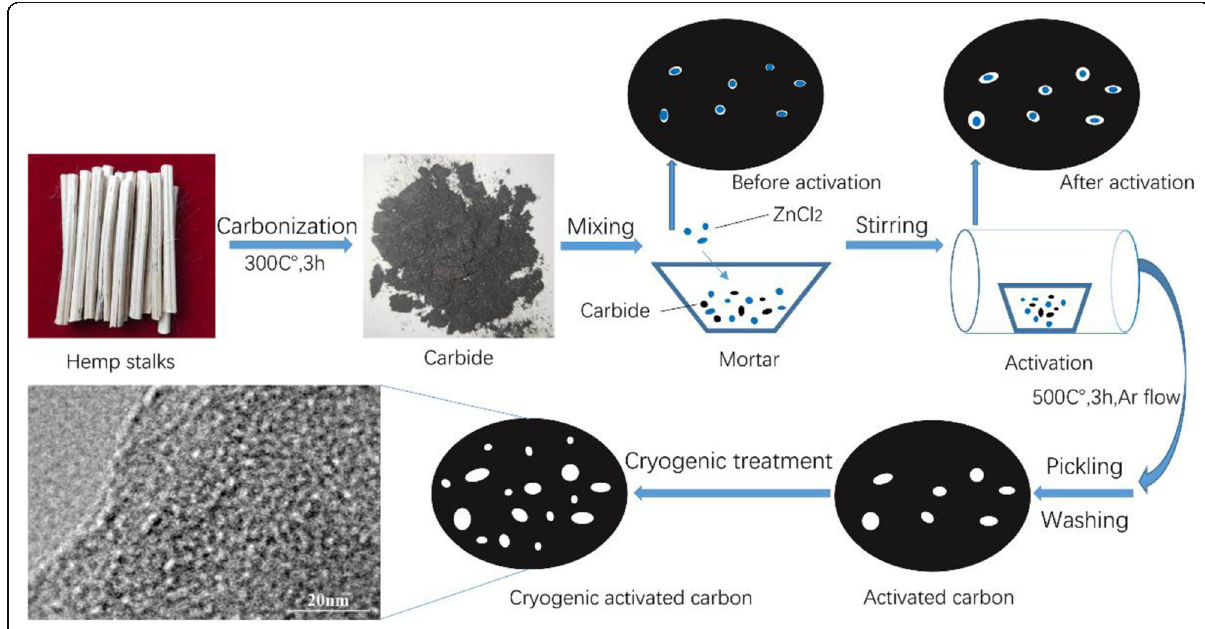
Fig. 1 Schematic illustrations for preparing cryogenic activated carbon with porous